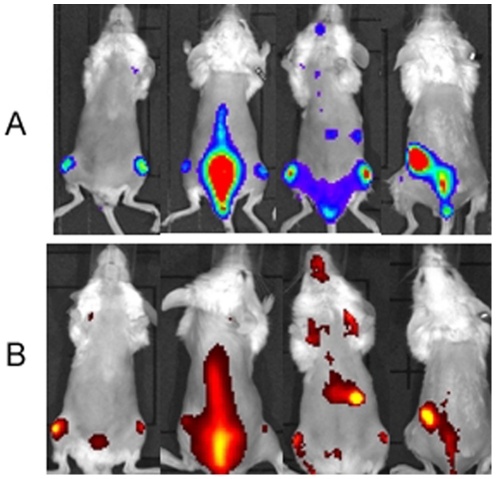
Bioluminescent (A) and fluorescent (B) images of HL60-Luc tumor-bearing mice 24h post-injection of 5 µg fluorescent CD45 mAb.